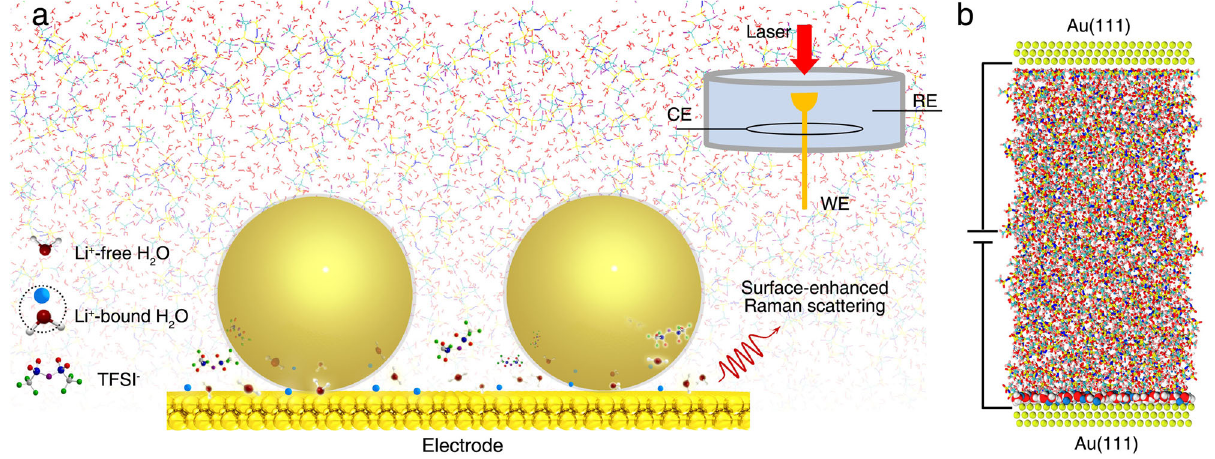
Fig. 1 | Probing the electrochemical double-layer structure at the electrode| electrolyte interface. a Schematic of in situ probe of the EDL using SHINERS method. Bottom left: schematic structure of the Li + -free water, Li + -bound water molecules, and TFSI − anion, respectively; Top right: schematic of a spectro- electrochemical cell, where an Au(111) electrode, a Pt wire, and an Ag/AgCl